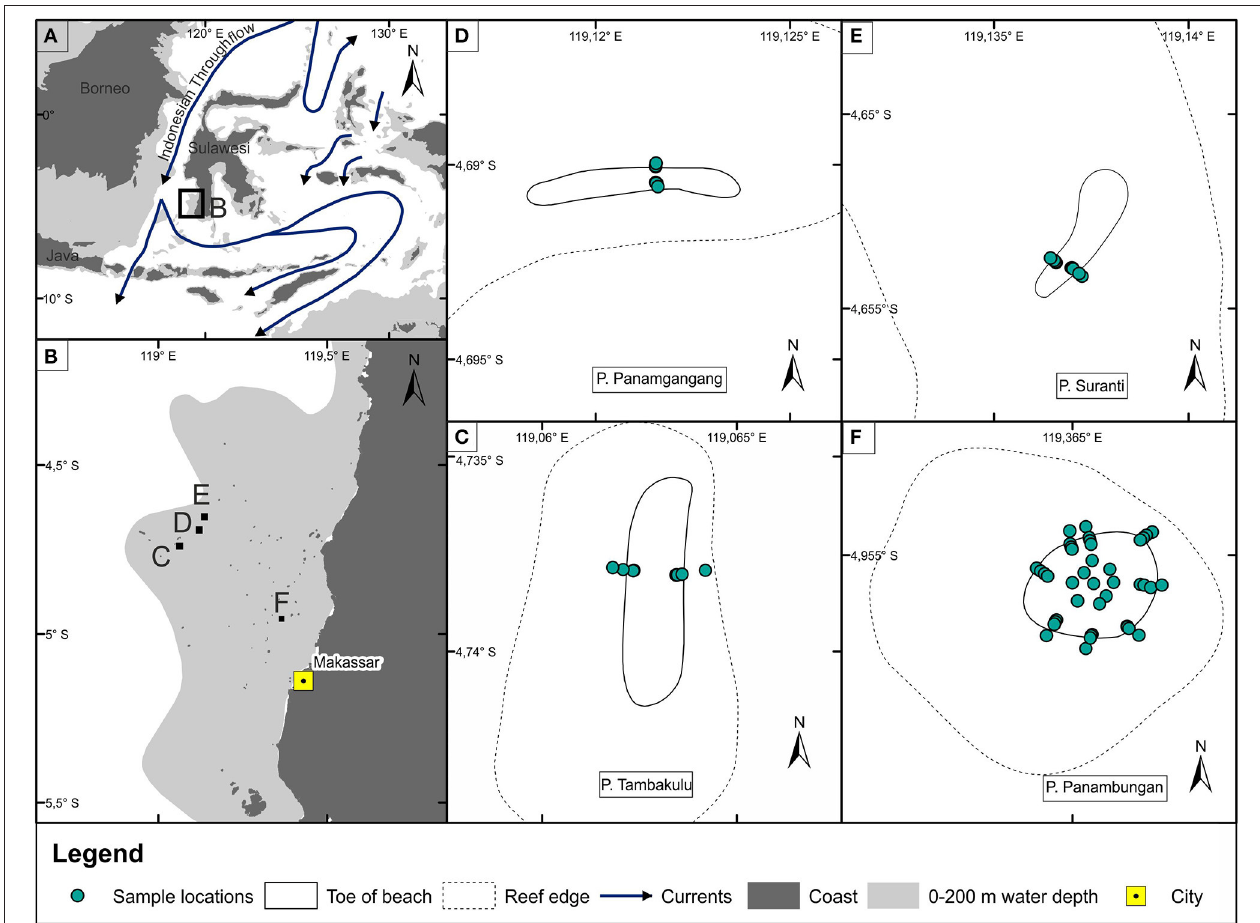
FIGURE 1 | Overview map of (A) Southeast Asia with the major ocean currents (adopted from Ding et al., 2013). (B) Spermonde Archipelago showing the locations of the four investigated islands. (C–F) Study islands Pulau Tambakulu, Pulau Panamgangang, Pulau Suranti and Pulau Panambungan and locations of the surface sediment samples (green